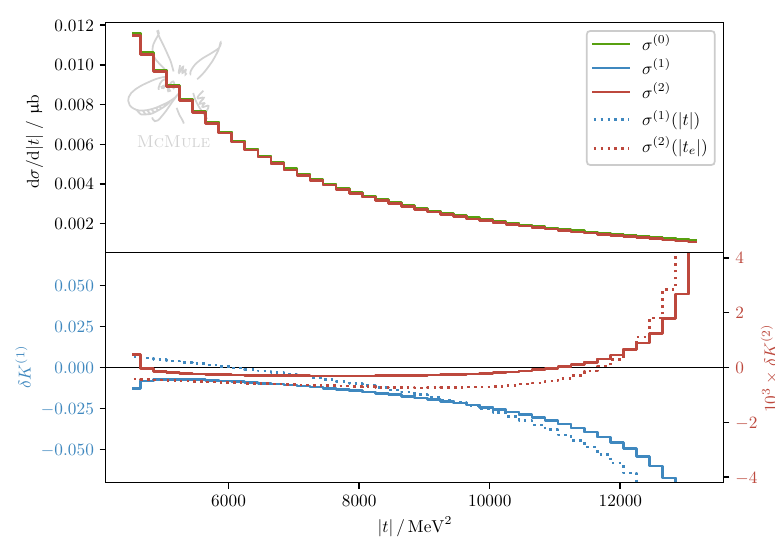
Figure 10: Differential cross section d σ/ d | t | for a P2 setting at LO (green) and NNLO (red) with K factors. Solid (dotted) K factors are determined from proton (electron)